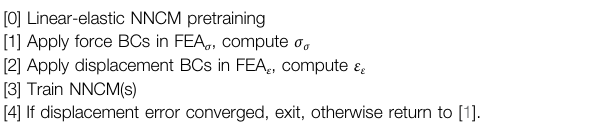
Algorithm 2 | AutoP Training of